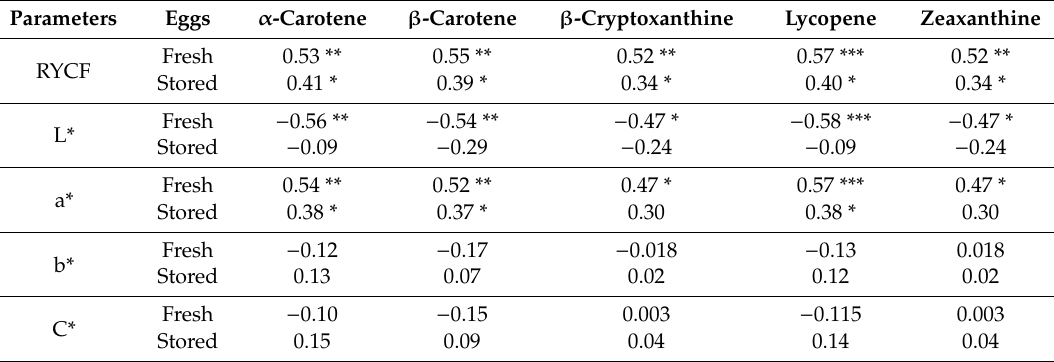
Table 6. Correlation between fresh and stored egg yolk coloration and carotenoid